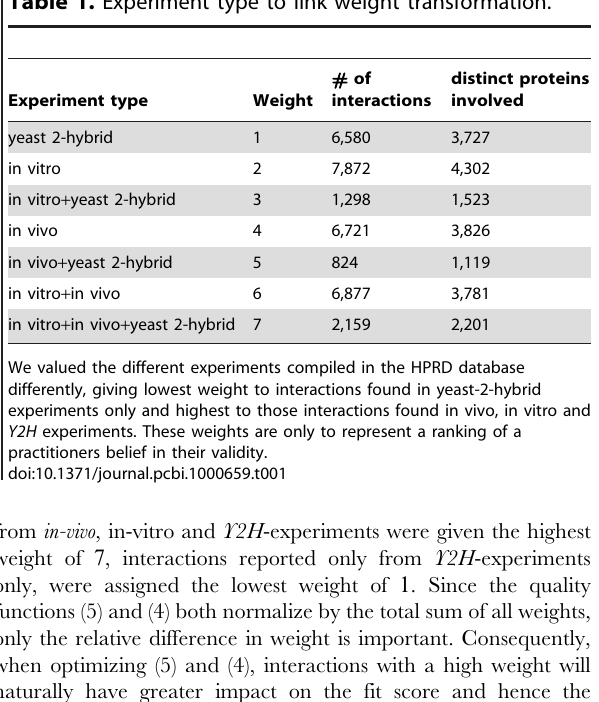
Table 1. Experiment type to link weight transformation.